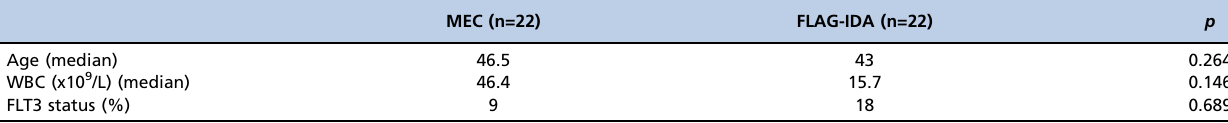
Supplementary Table - Comparison of baseline characteristics between the two groups in the post-matched